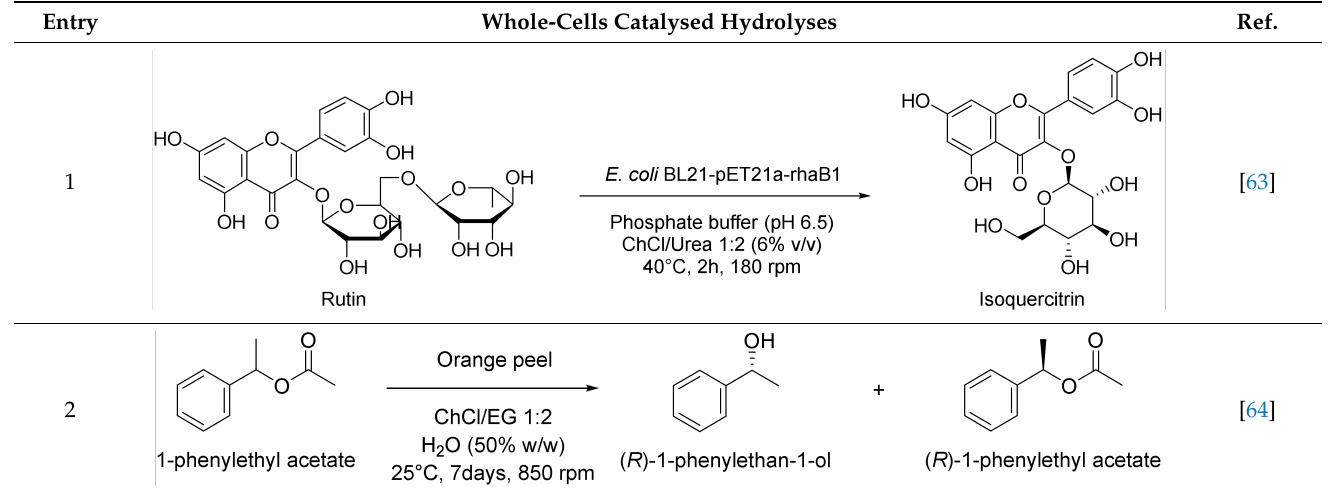
Table 6. Whole-cells catalysed hydrolyses.